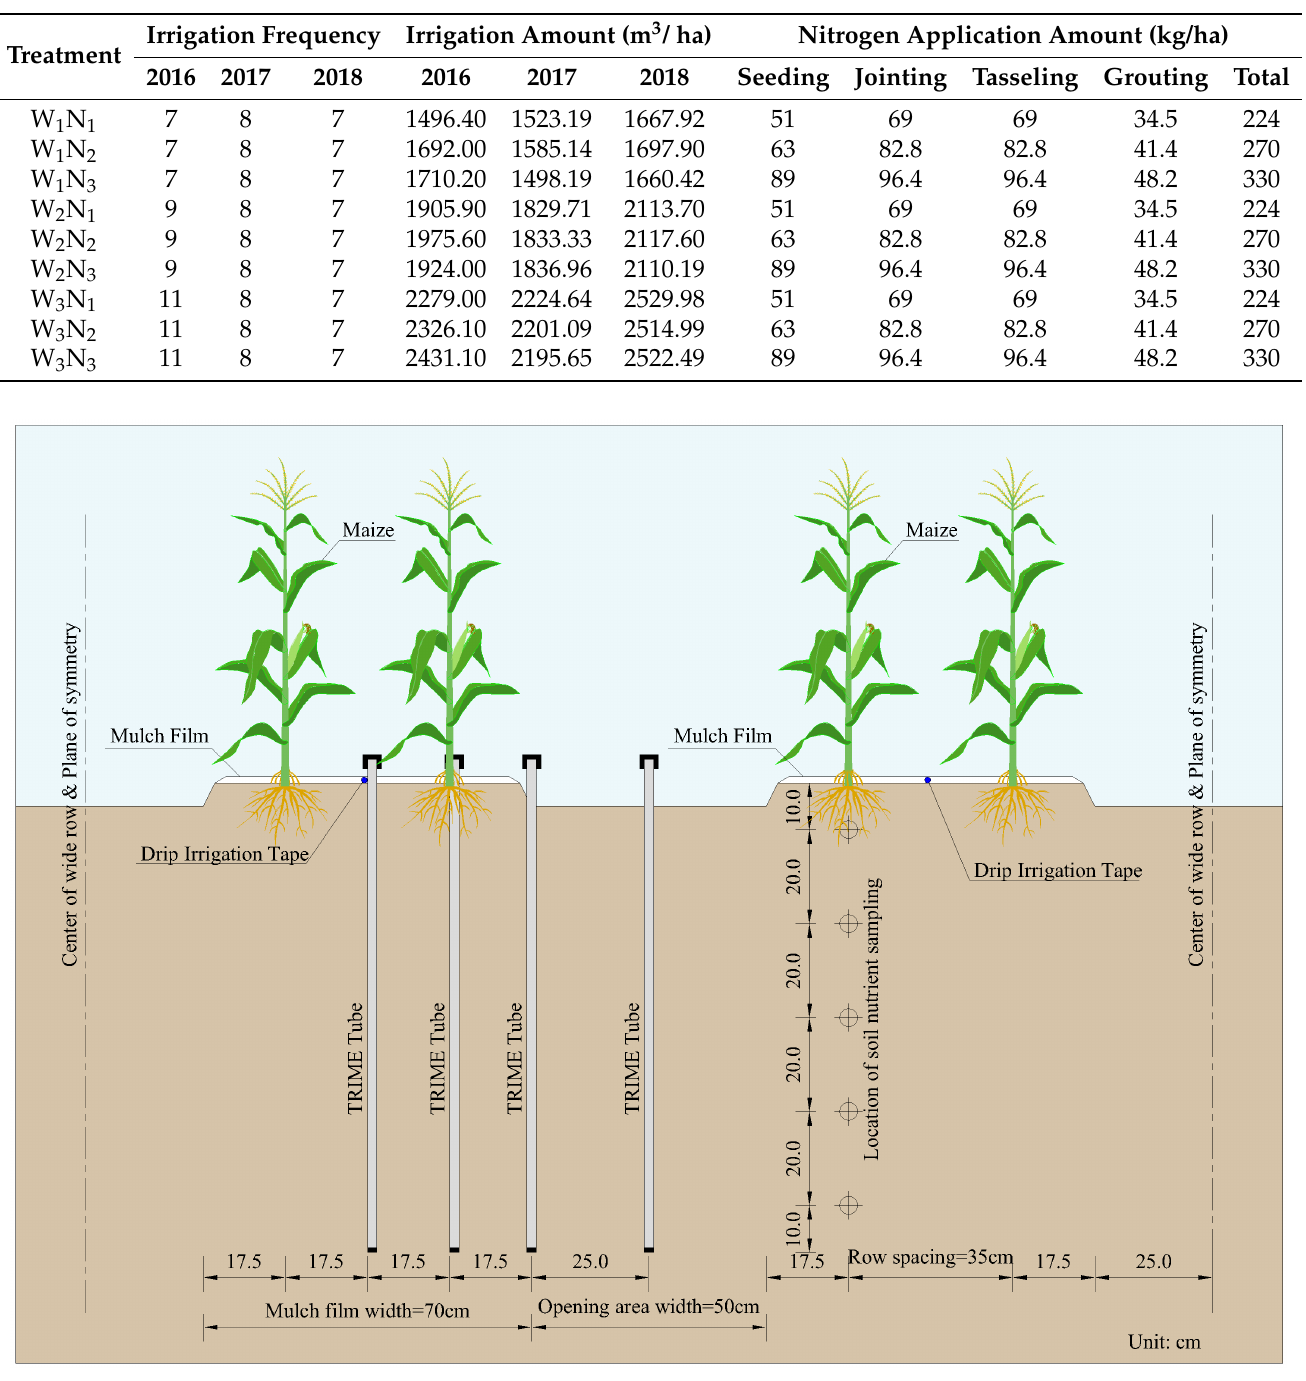
Table 2. Test scheme of water–nitrogen coupling effect on maize.